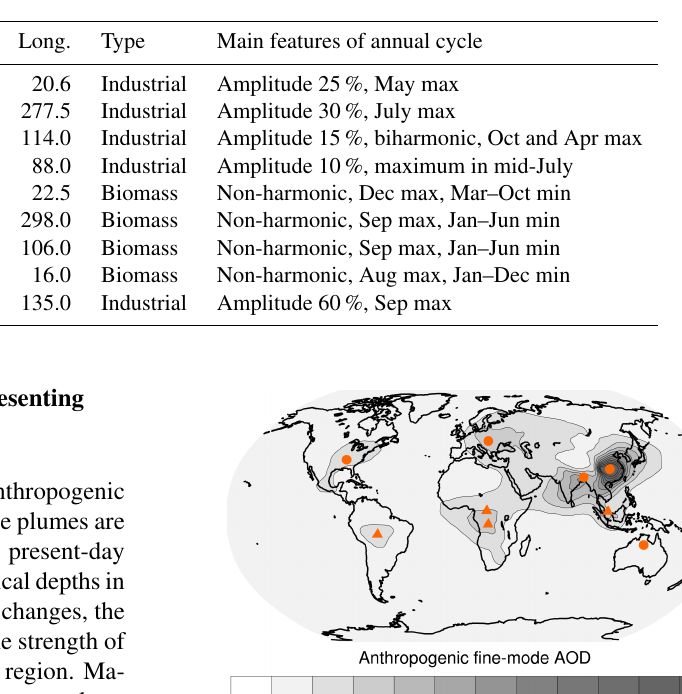
Table 1. Names, location and characteristics of individual plumes. Plumes which have a non-harmonic contribution to their annual cycle have larger amplitude (90–100%) annual variations.